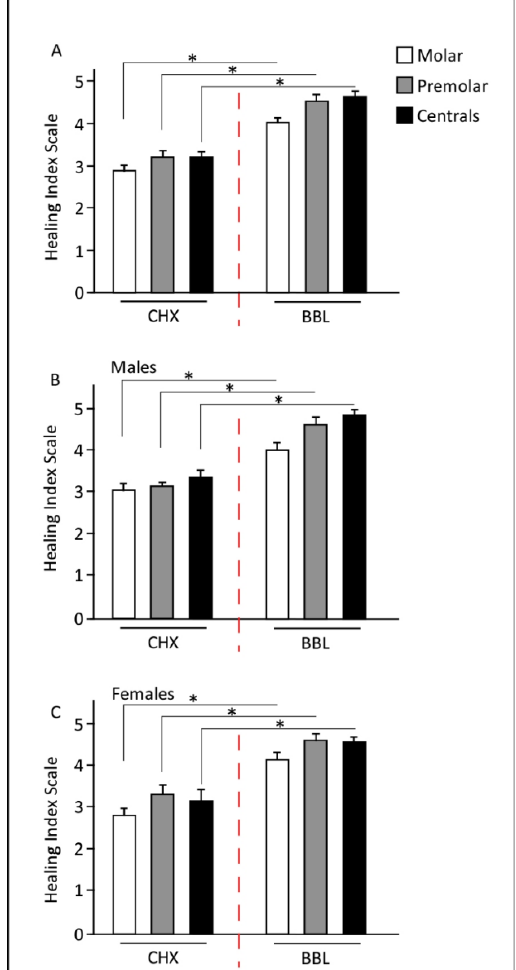
Figure 3. Early wound healing index (EHI) scores at day 7. ( A ) EHI scores were independent of tooth position and were significantly higher in BBL treatments. ( B,C ) Comparison between genders. Males and females responded similarly for both treatments, with a significant improvement in EHI post BBL treatment. * p < 1 × 10 −4 .